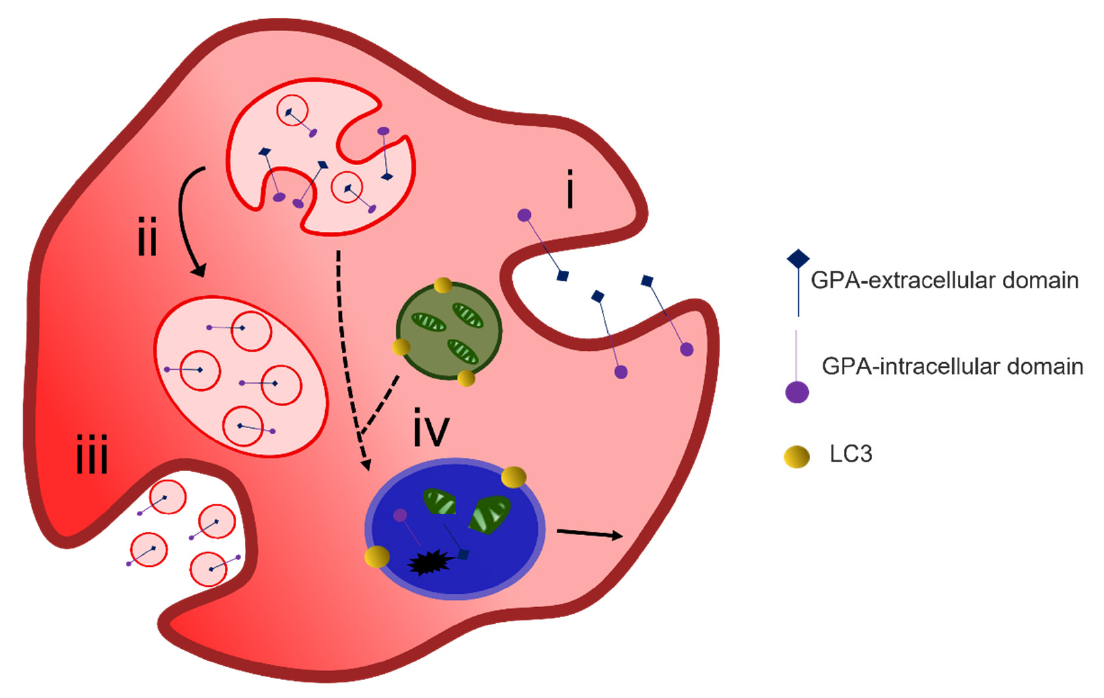
Figure 4. Exocytosis-mediated reticulocyte maturation. During reticulocyte maturation unwanted membrane proteins are endocytosed (i) and sorted into multivesicular bodies (ii) that are released as exosomes via the fusion of MVB membrane with the cell plasma membrane (iii). LC3-positive autophagosomes containing degraded organelles may also fuse with MVB and lysosomes (iv) and form autophagolysosomal vacuole where cargo degradation occurs or alternatively exits the cell via membrane budding.